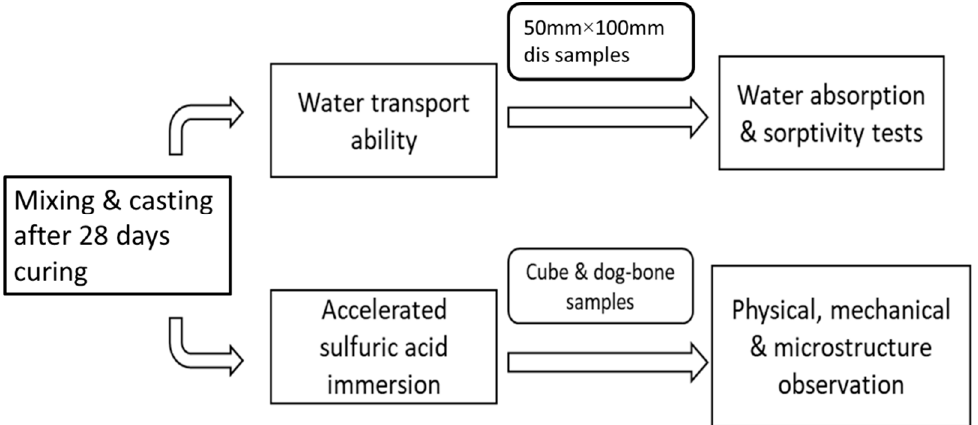
Figure 3. Testing procedure.